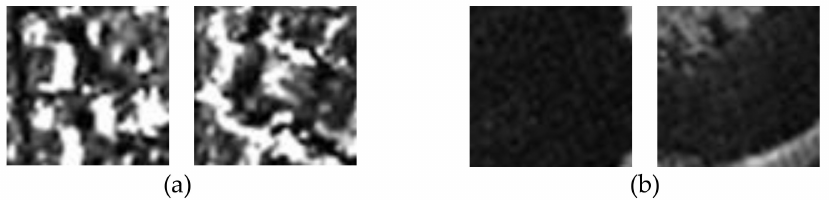
Figure 1. ( a ) High intra-class diversity of low-density residential areas. ( b ) Little inter-class difference between open land (left) and water